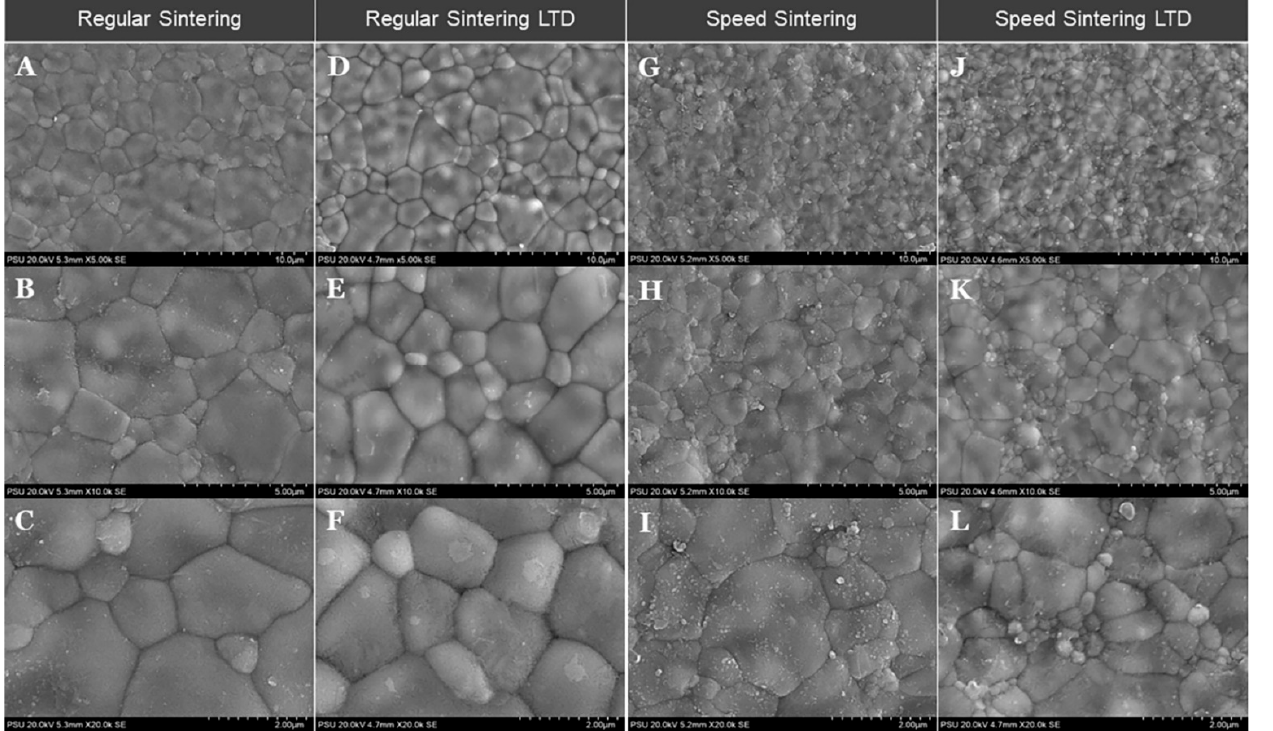
Figure 5. Scanning electron microscopy images of the zirconia specimens for the regular sintering and speed sintering with and without low-temperature degradation (LTD). Regular sintering ( A – F ) and speed sintering ( G – I ) from low magnification to high magnification. Table 1. Results of the grain sizes of the zirconia specimens in various groups. Groups Mean (µm) Regular